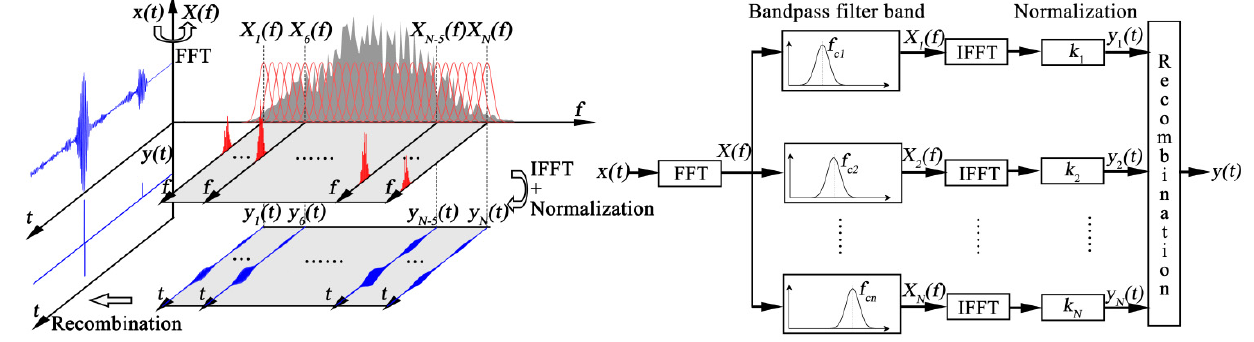
Figure 1. Schematic diagram of split spectrum processing (SSP).